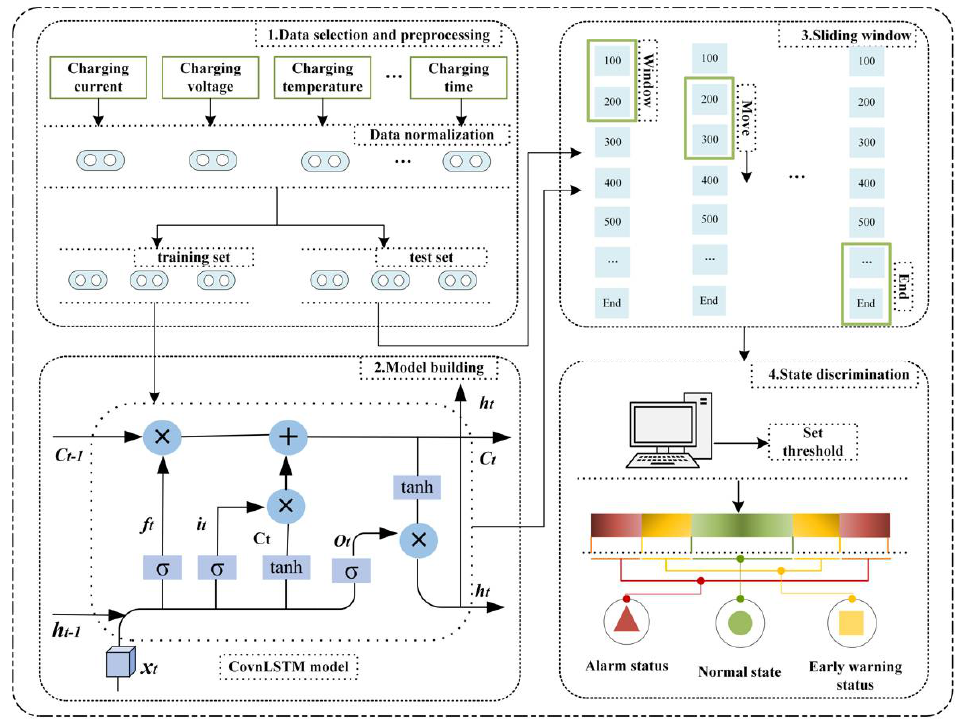
Figure 2. Diagram of safety pre-warning system for the electric vehicle charging.